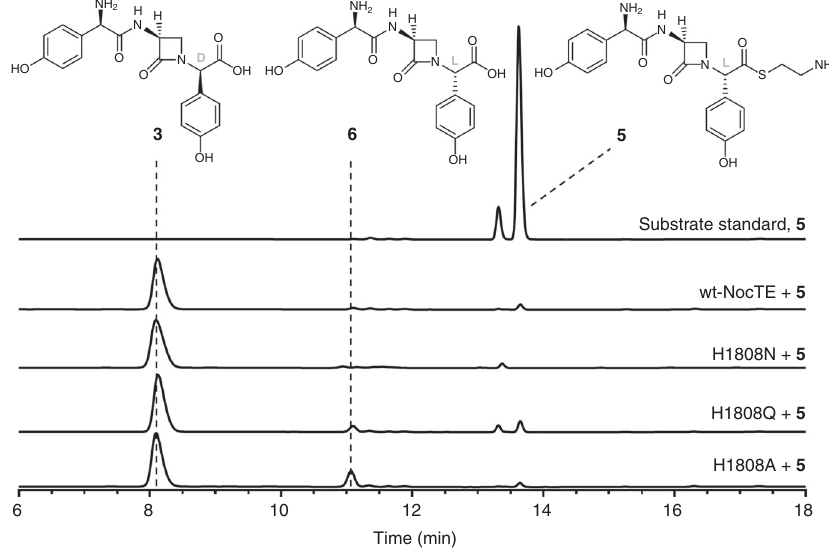
Fig. 3 Mutational analysis of His1808. Wild-type or mutant NocTE was incubated with the SNAC thioester of the epi -nocardicin G 5 and monitored by HPLC for its ability to catalyze epimerization and hydrolysis to 3 or hydrolysis to 6 . Chromatograms for assays were monitored at 272 nm. Mutation of His1808 had little impact on catalytic activity, but the fraction of 6 in the product rises from ≤ 1% in wild type to ~15% in the H1808A